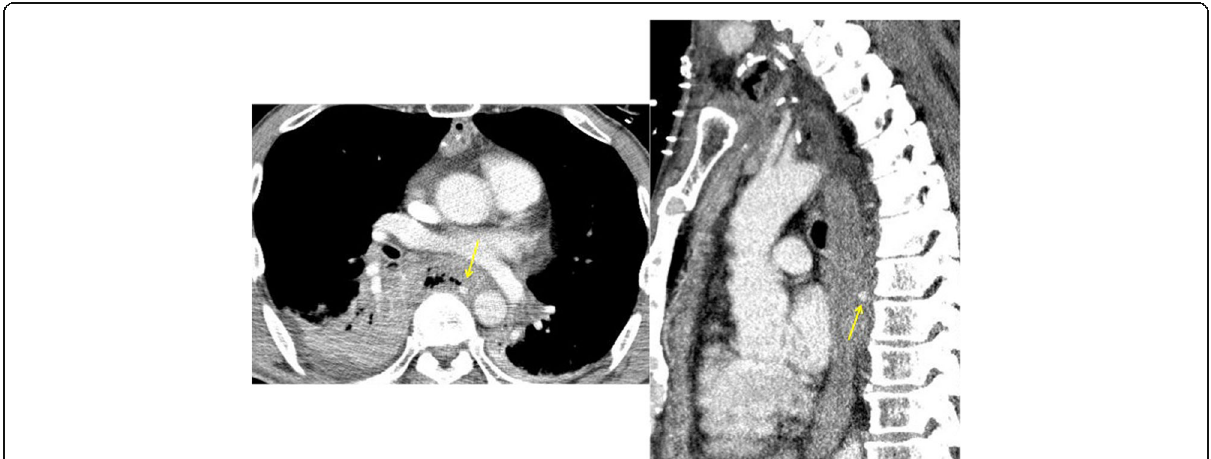
Fig. 4 Enhanced computed tomography on hemoptysis revealed contrast medium extravasation, indicating a pseudoaneurysm ( arrow ) at the mediastinum